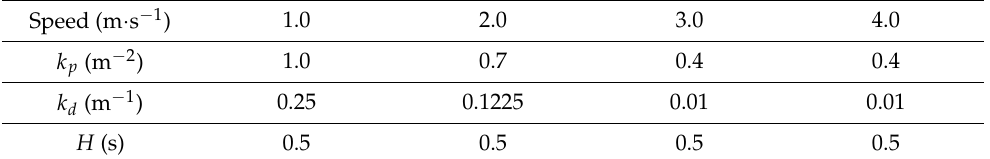
Table 1. Control parameters used with Romea